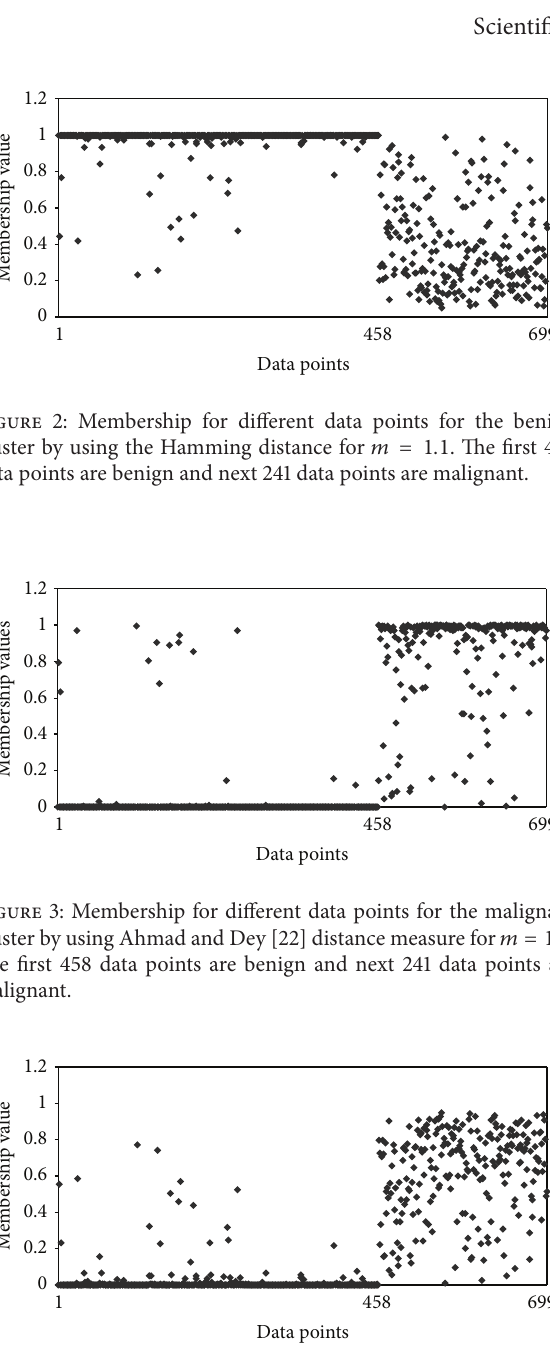
Figure 4: Membership for different data points for the malignant cluster by using the Hamming distance for 𝑚 = 1.1 . The first 458 data points are benign and next 241 data points are malignant.